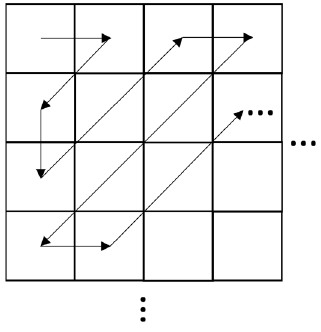
Figure 6. The zigzag rule of the discrete cosine transform.